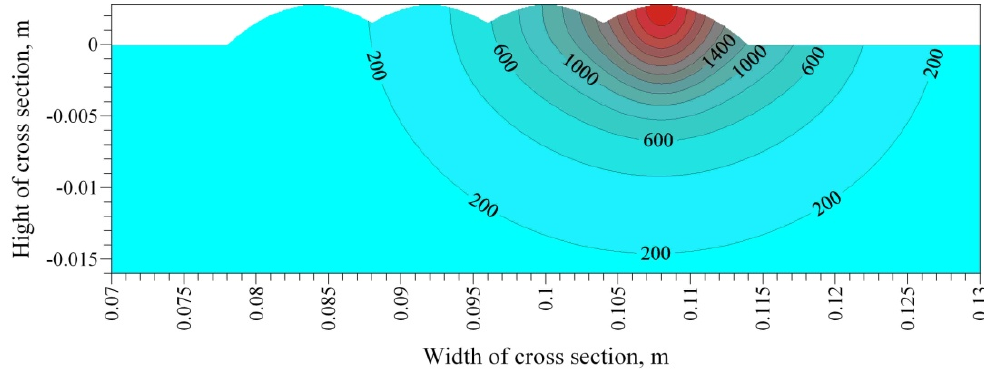
Figure 11. Temperature field (°C) in cross ‐ section during the application of fourth weld 0.5 s after passage of the electrode over this cross ‐ section.